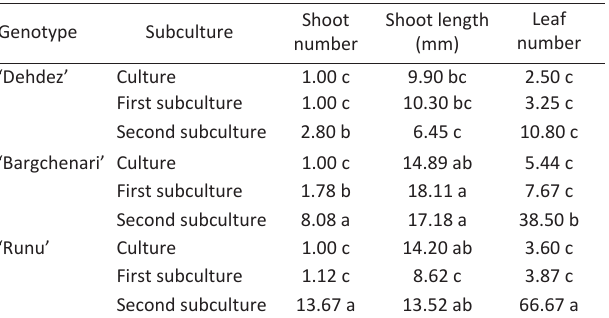
Table 2 - Effects of genotype and subculture on shoot numbers, shoot length and leaf numbers per explants on MS